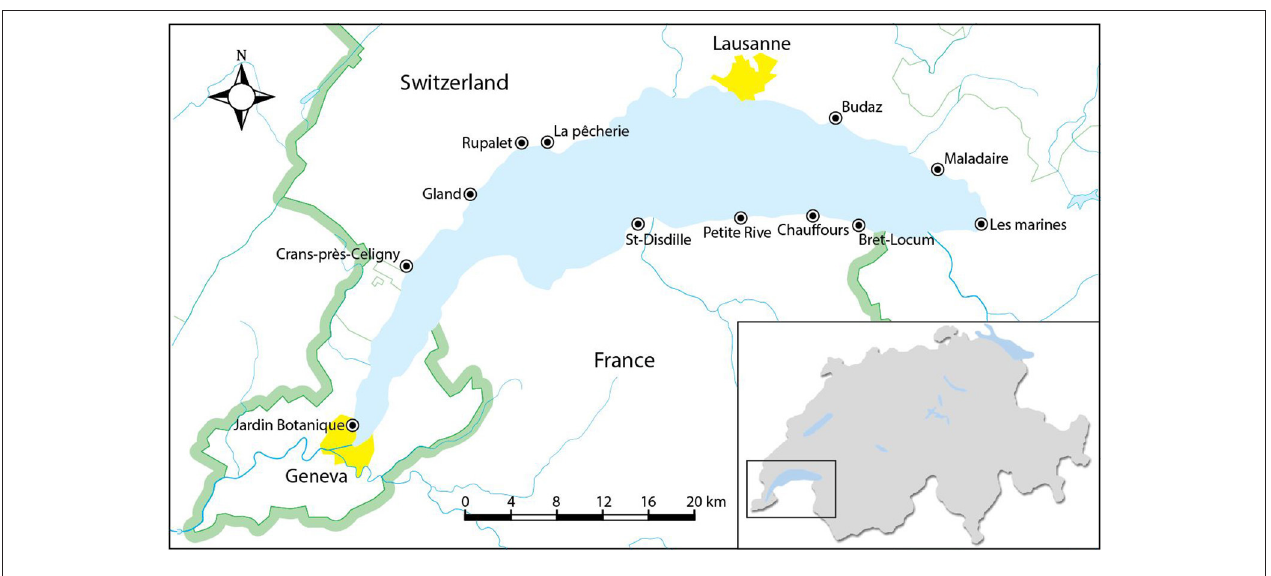
FIGURE 1 | Location of the 12 beaches sampled in Lake Geneva.